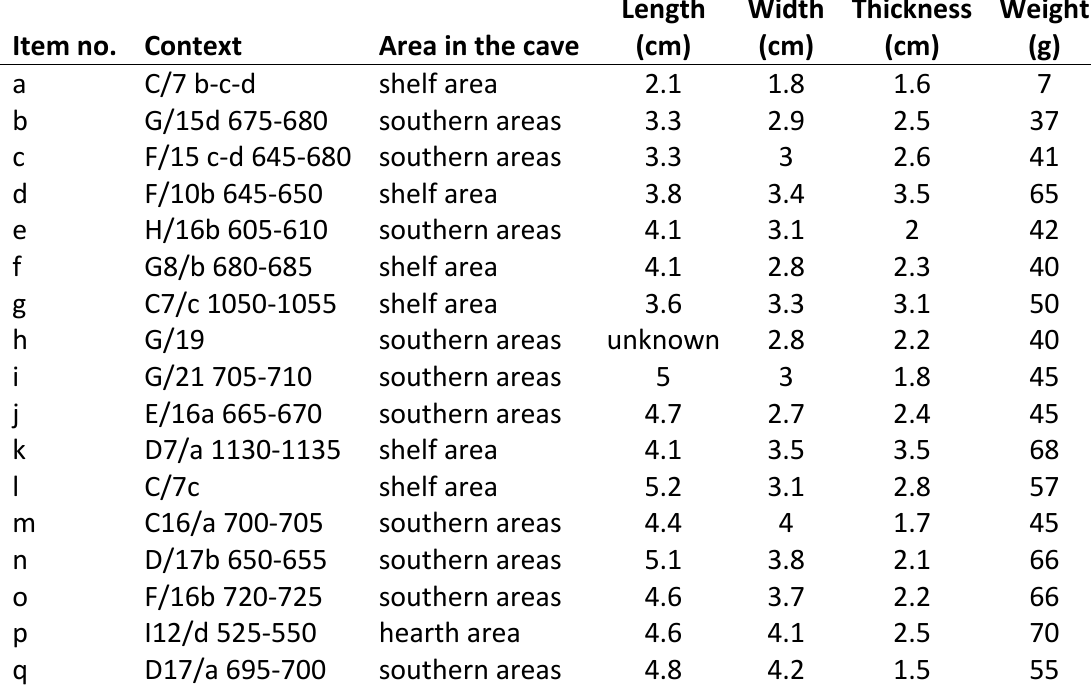
Table 1. The archaeological context of the pebbles within the cave. Item